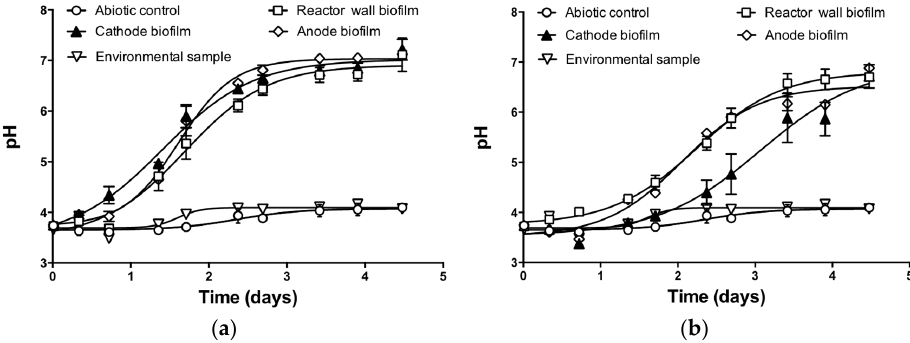
Figure 4. pH evolution in batch cultures of microorganisms present at electrodes and reactor walls from reactor “a” ( a ) and reactor “b” ( b ). Biofilms were used as inocula for cultures under initial acidic conditions (pH = 3.7, 1.3 g ∙ L − 1 Pyruvate). Batch experiments were performed at room temperature (~20 °C), conditions (pH = 3.7, 1.3 g · L − 1 Pyruvate). Batch experiments were performed at room temperature (~20 ◦ C), with an initial cell concentration of ~5.5 × 10 8 cells · mL − 1 . The data are presented as mean ± SD (error bars) ( n = 2). Abiotic control and environmental sample culture were also included in the